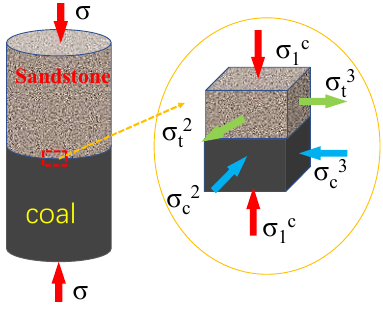
Figure 7. Local stress analysis of the coal–rock assemblage.